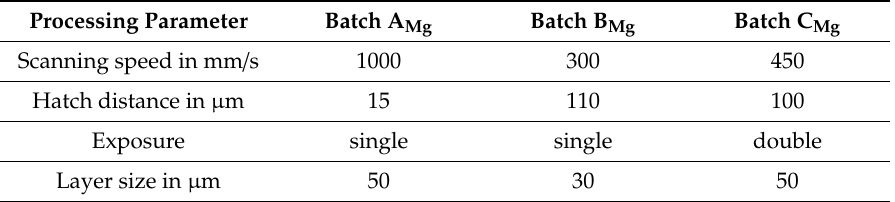
Table 1. Parameter settings for magnesium specimens.